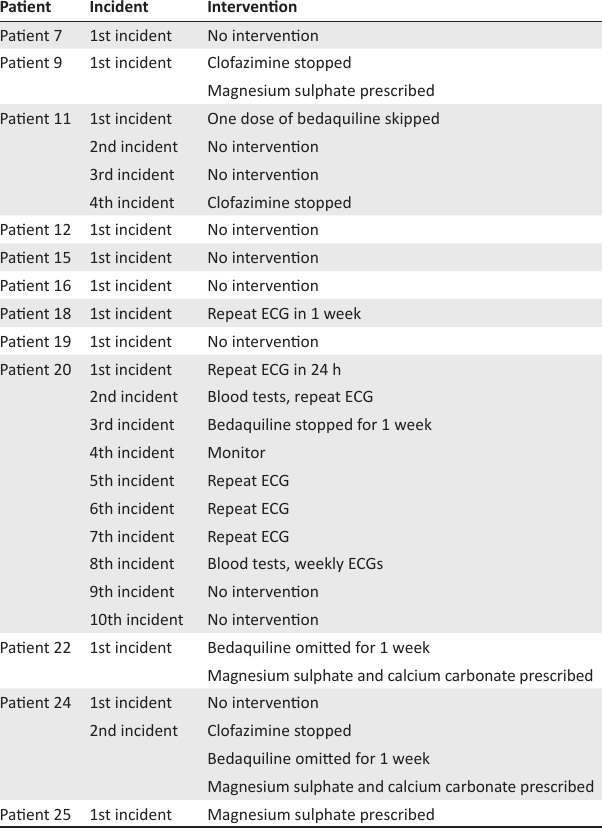
FIGURE 1: Adverse effects experienced by patients while on bedaquiline treatment ( N = TABLE 1: Clinical interventions for corrected QTs interval prolongation.